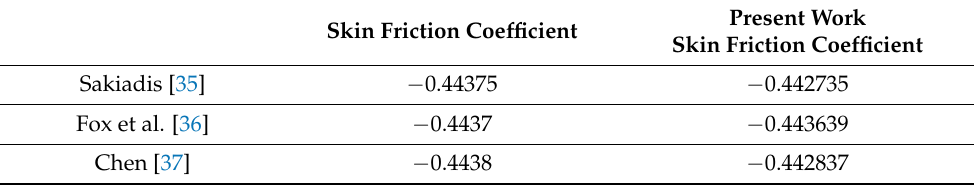
Validation of the numerical results for skin friction coefficient by